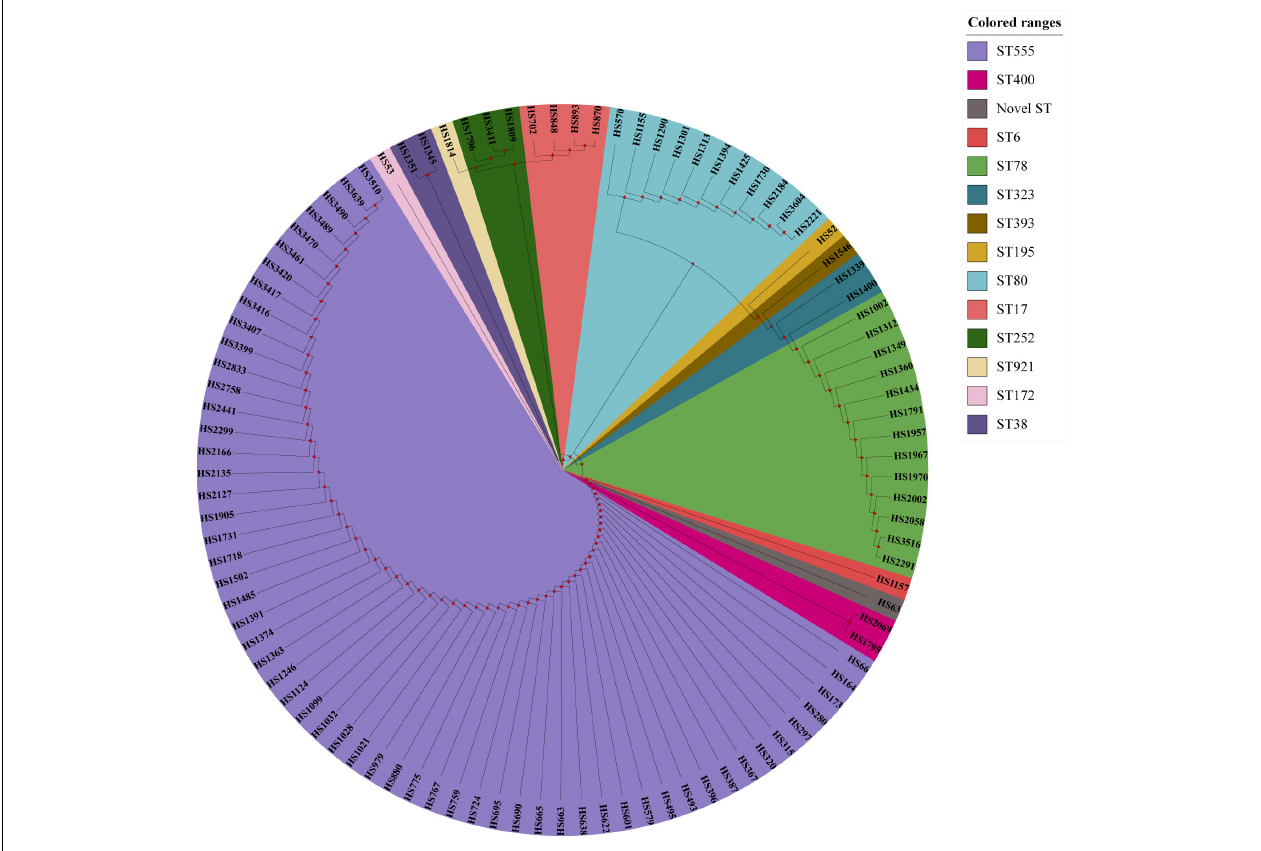
FIGURE 1 | The MLST results of 101 E. faecium carrying fos X